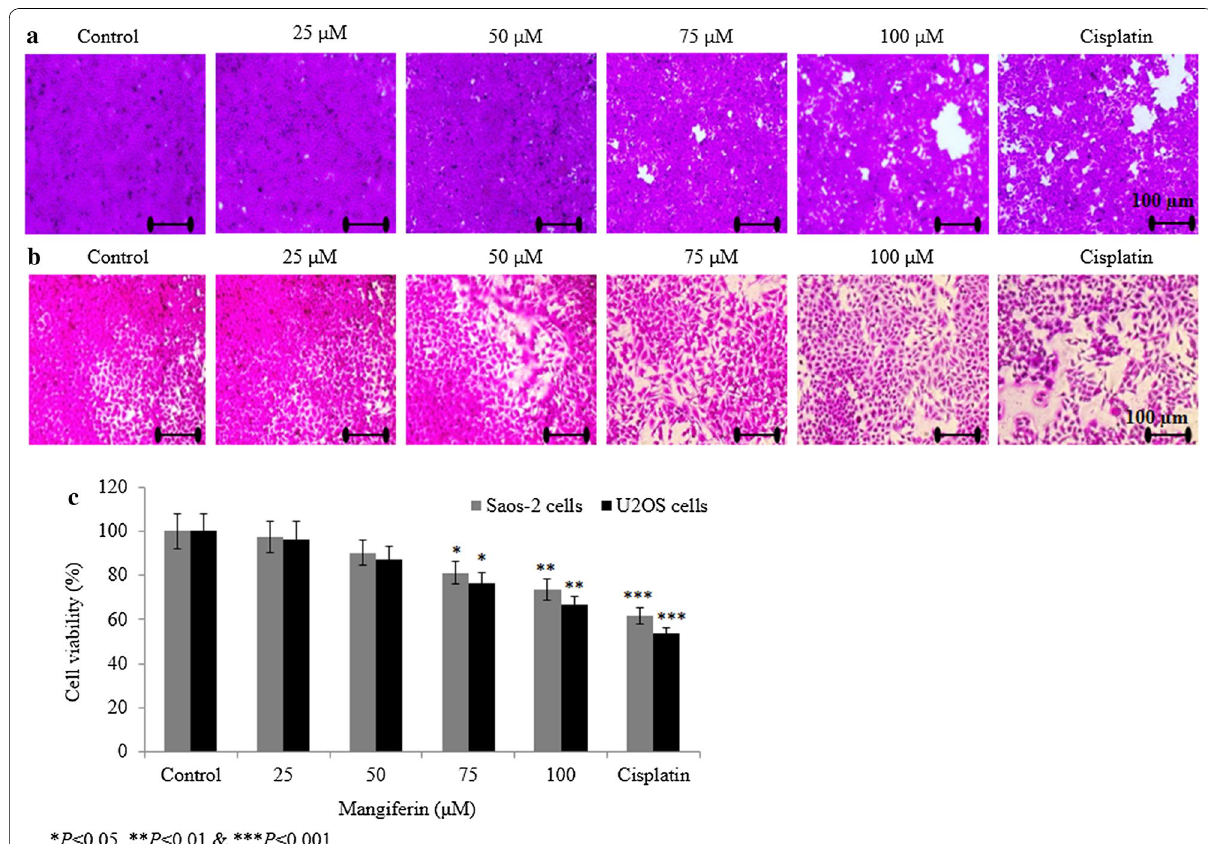
Fig. 1 Mangiferin inhibits the cell viability of metastatic osteosarcoma cell. Cancer cells were incubated with mangiferin (25–100 µM) for 72 h. a Saos-2 cell viability. b U2OS cell viability and c percentage analysis of a and b . Scale bar